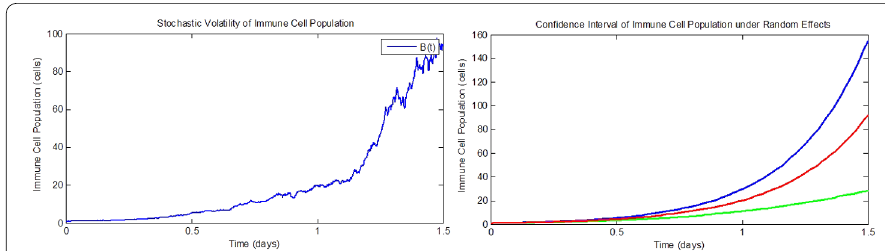
Figure 17 Stochastic volatility and confidence interval of B ( t ), respectively.